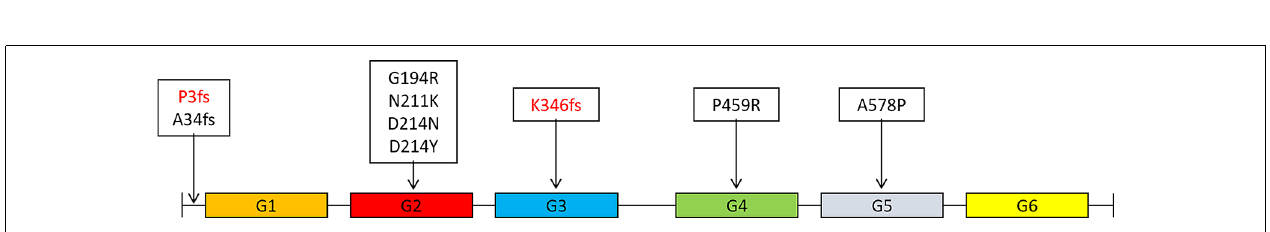
examinations during the follow-up. PET-CT revealed: (1) FDG imaging showed no abnormal increase or decrease in glucose metabolism in the brain; (2) PIB imaging showed no abnormality of imaging agent uptake in cerebral cortex, and suggested